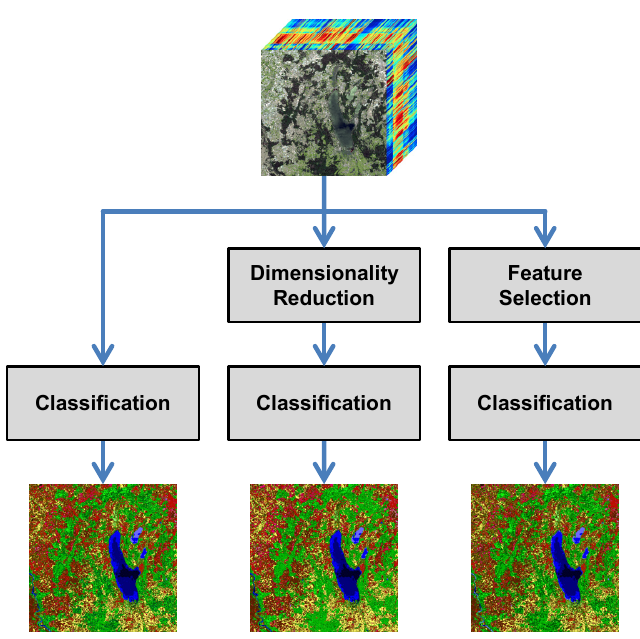
Figure 1. Overview on the proposed framework allowing for three different options for the data representation as input for a standard supervised